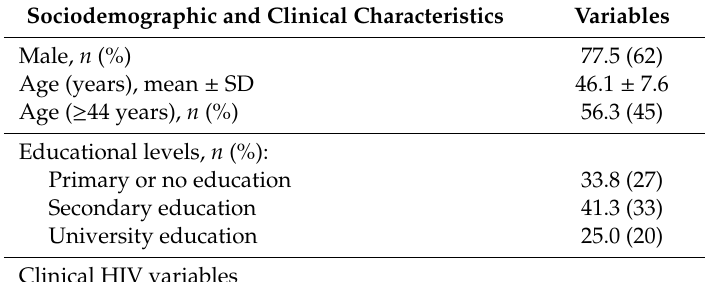
Table 1. Descriptive analysis of people living with HIV (PLWHIV) included in the study ( N = 80). Sociodemographic and Clinical Characteristics Variables